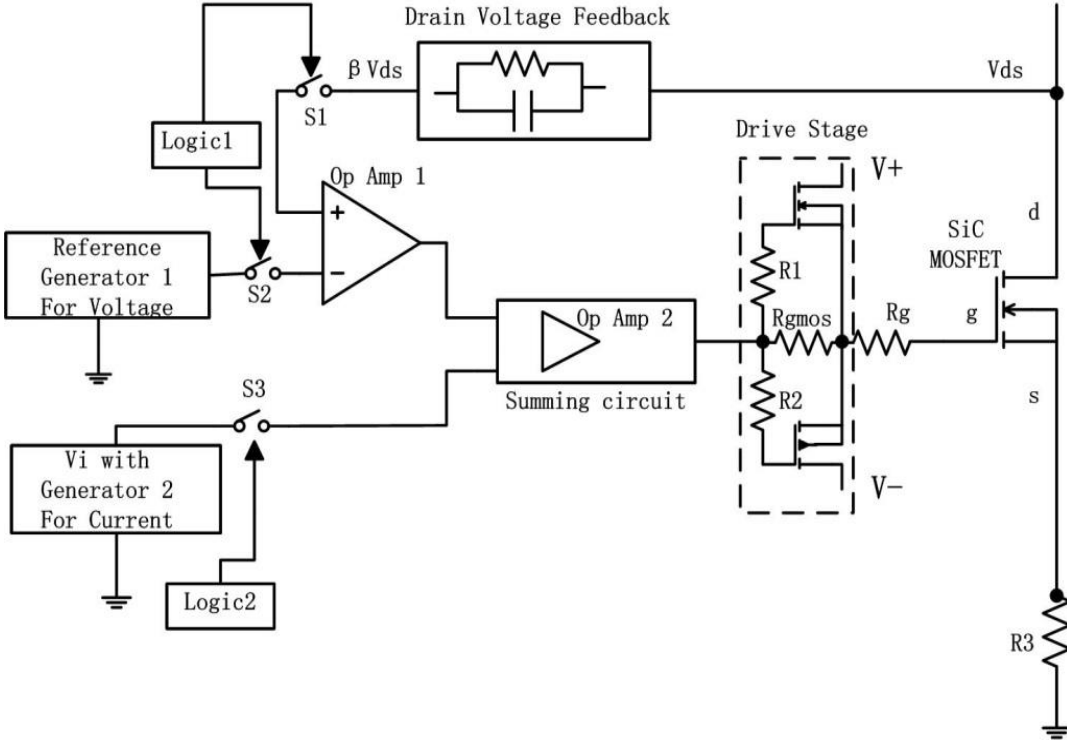
Figure3. Figure 3. The general scheme of control method for the proposed time division shaped switching transitions.